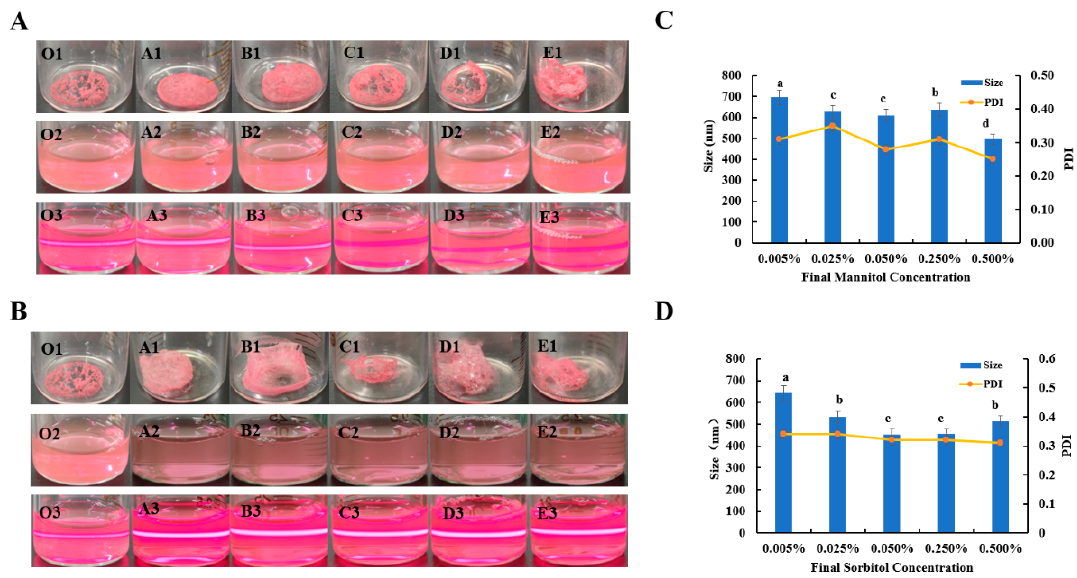
Figure 4. Effect of different concentrations of alcohols (mannitol, sorbitol) on ABC-NPs lyophilized powder: the appearance of ABC-NPs (lyophilized powder, re-soluble state, and Tyndall effect) ( A , B ) and particle size ( C , D ).